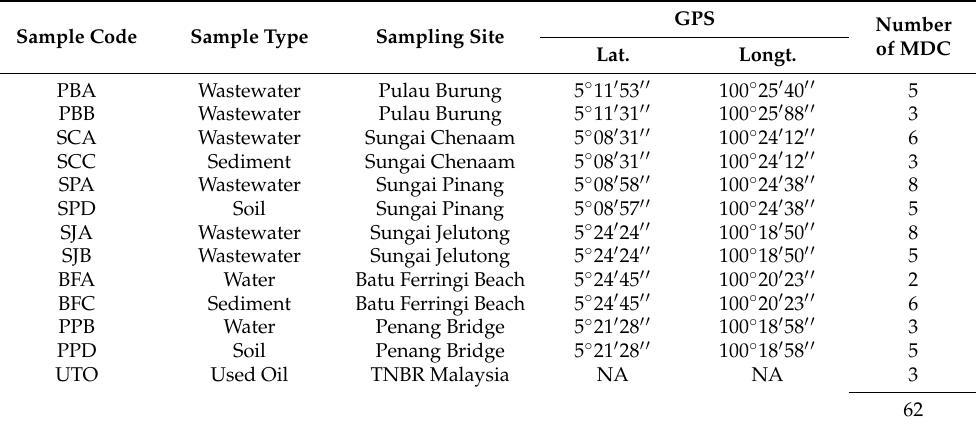
Table 1. The abundance of used transformer oil-degrading bacteria in the various environmental samples collected in Penang.